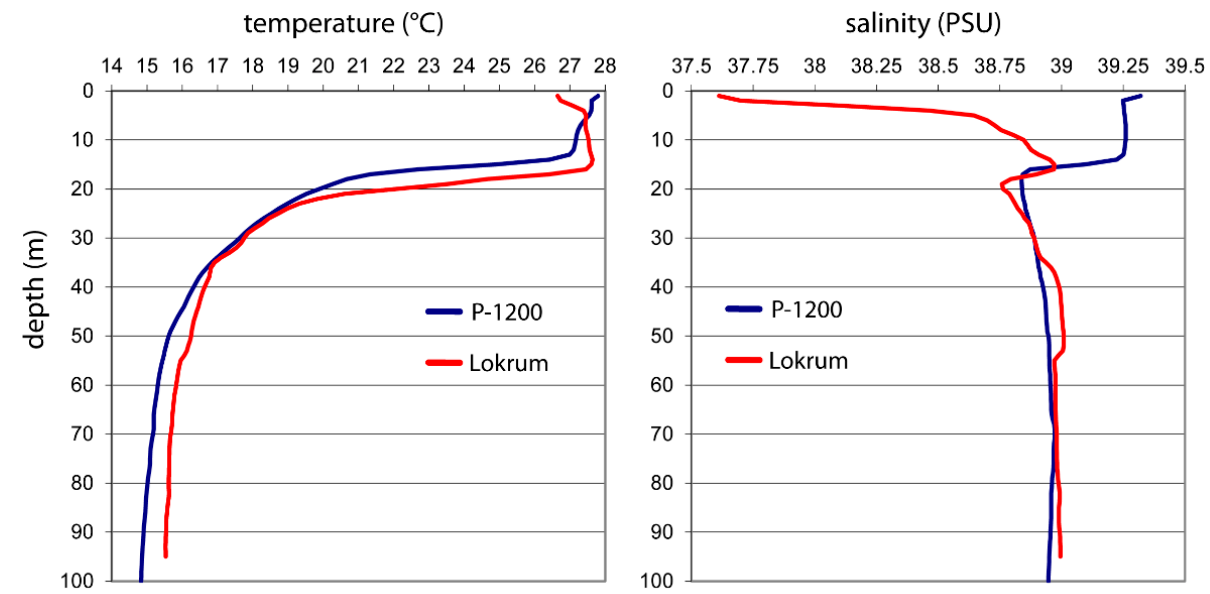
Figure 2. Temperature and salinity at stations P-1200 and Lokrum in August 2021.